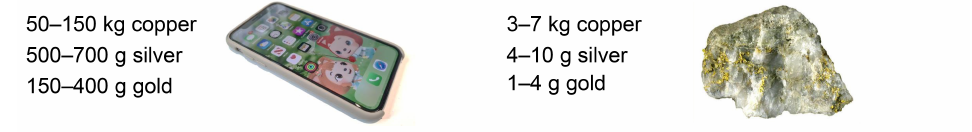
Figure 2. Comparison of the amount of various metals yielded from recycled mobile phones com- pared to primary ore [35].